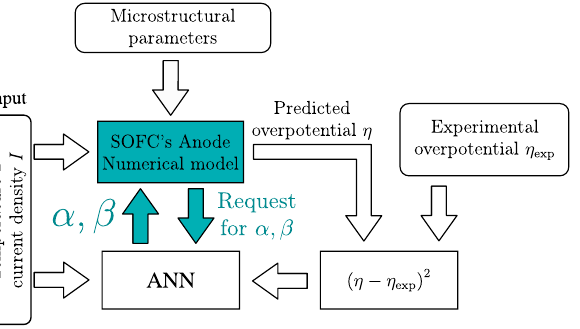
Figure 14. Architecture schema of the IMANN in application to SOFC’s anode microscale modeling. Data available in the literature [56] was used as a source of microstructural parameters, typically used charge transfer coefficients’ values and both training and test datasets.